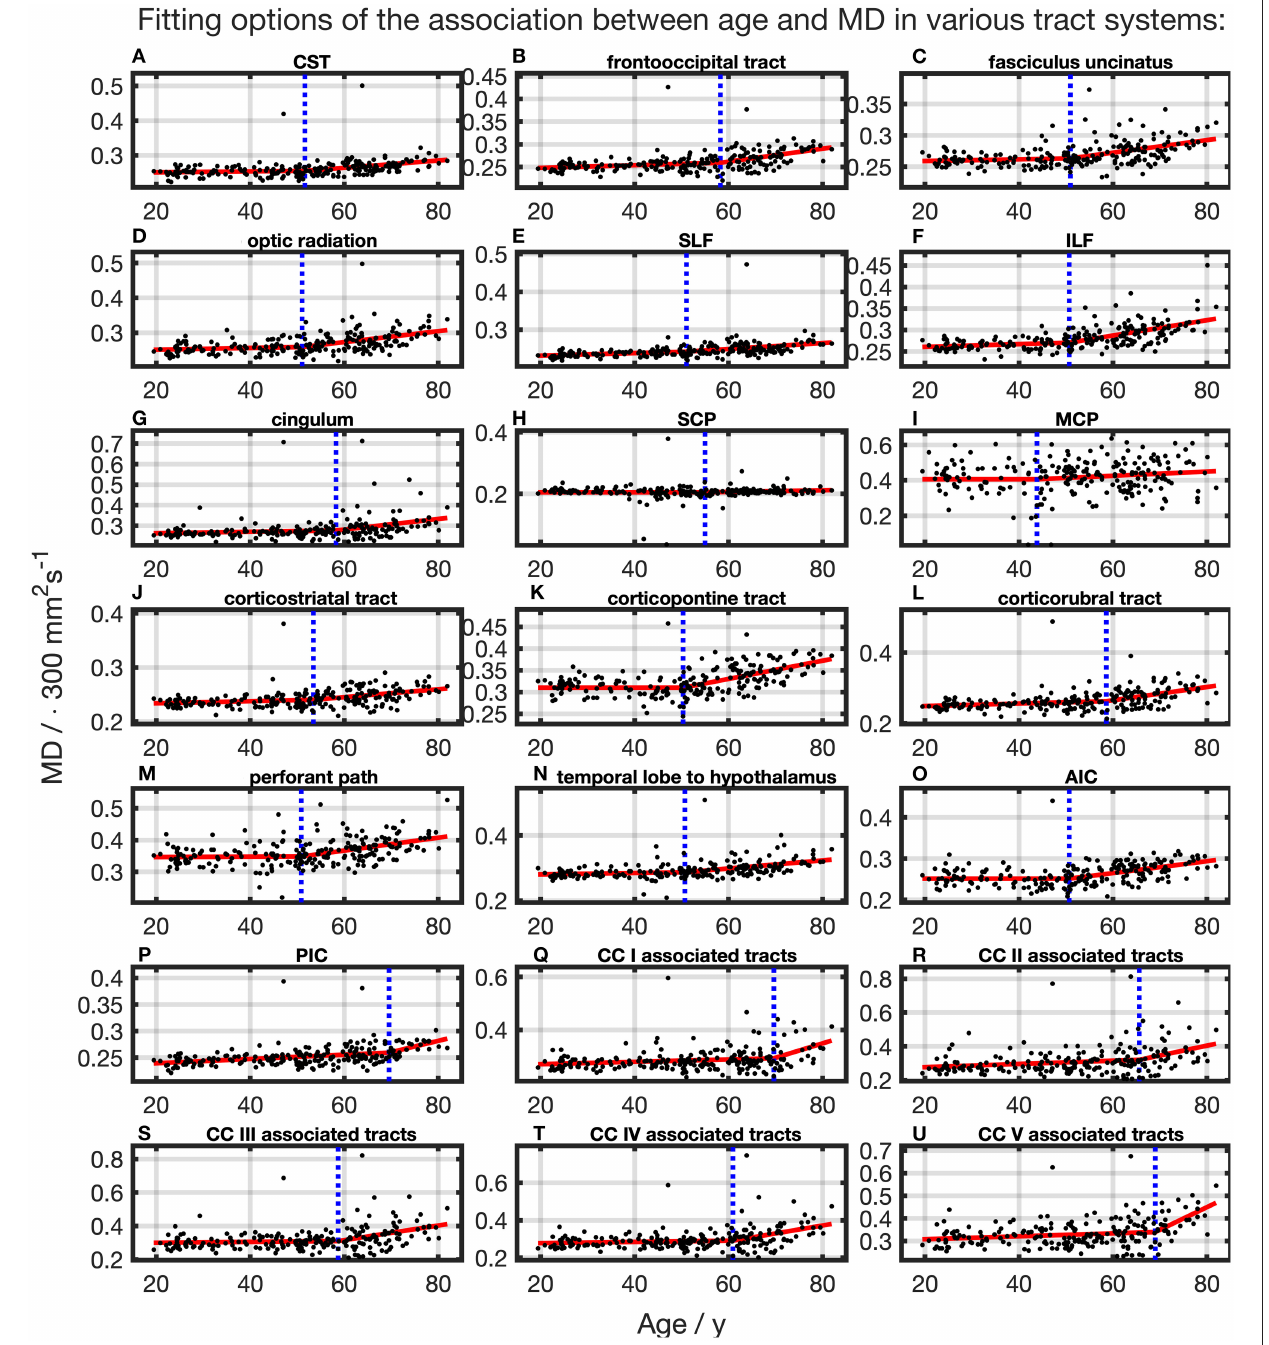
FIGURE 5 | Scatter plots (black) and regression line (red) of the association between age and MD in various tract systems. (A–U) In all tract systems, data were fitted with linear splines. The position of the knot between two linear curve segments is given as a blue dashed line (CC, corpus callosum; CST, corticospinal tract; SLF, superior longitudinal fasciculus; ILF, inferior longitudinal fasciculus; SCP, superior cerebellar peduncle; MCP, middle cerebellar peduncle; AIC, anterior limb of internal capsule; PIC, posterior limb of internal capsule).